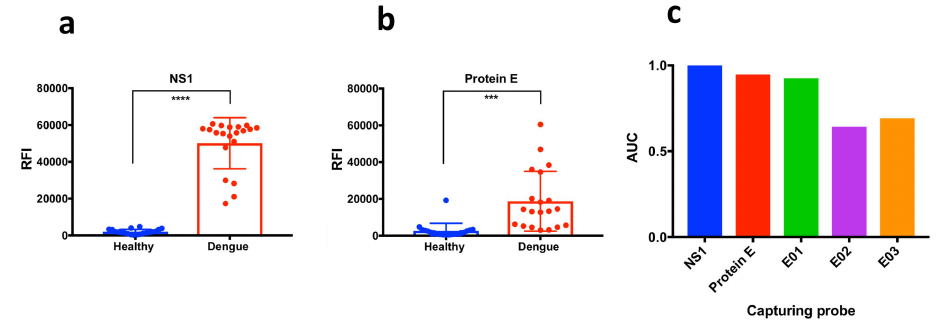
Figure 4. Scatter plots reporting individual and mean immunoreactivity with SD of dengue positive and healthy control individuals and results of the unpaired t Test dengue infection diagnosis for NS1 ( a ) and protein E ( b ). ns = not significant. Significant: *** p < 0.001; **** p < 0.0001. ( c ) Comparison of Area under the Receiver Operating Characteristic (ROC) curve (area under the curve, AUC) for the di ff erent capturing probes. nonstructural protein 1 (NS1):1; Protein E: 0.9475; E01: 0.925; E02: 0.5225; E03: 0.61. For NS1 antigen the sensitivity and specificity of the test was 100% (95% CI: 83,16% to 100%) and 75% (95% CI: 50.9% to 91.34%) respectively. For the E protein the sensitivity and specificity of the test was 95% (95% CI: 75,13% to 99.87%) and 75% (95% CI: 50.9% to 91.34%) respectively. For E01 the sensitivity and specificity of the test was 100% (95% CI: 83.168% to 100%) and 75% (95% CI: 50.9% to 91.34%) respectively. ROC curves for NS1, protein E and E01 are reported in Figure S2 in the Supplementary Material. CI: Confidence